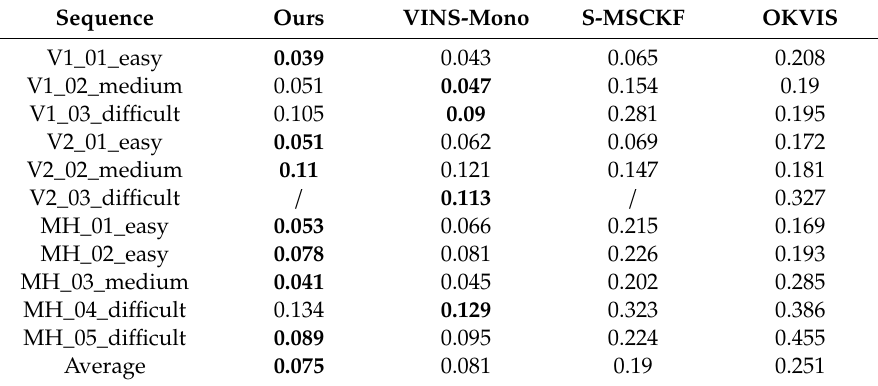
Table 2. RMSE of the algorithms